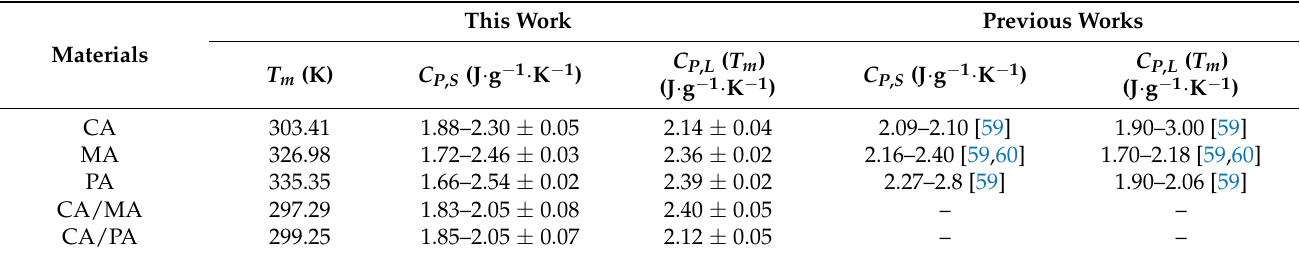
Table 8. Comparison of the specific heat capacities measured in the solid and the liquid states close to the melting temperature in this study and extracted from the literature [59,60] at pressure p = 0.1 MPa *. This Work Previous Materials